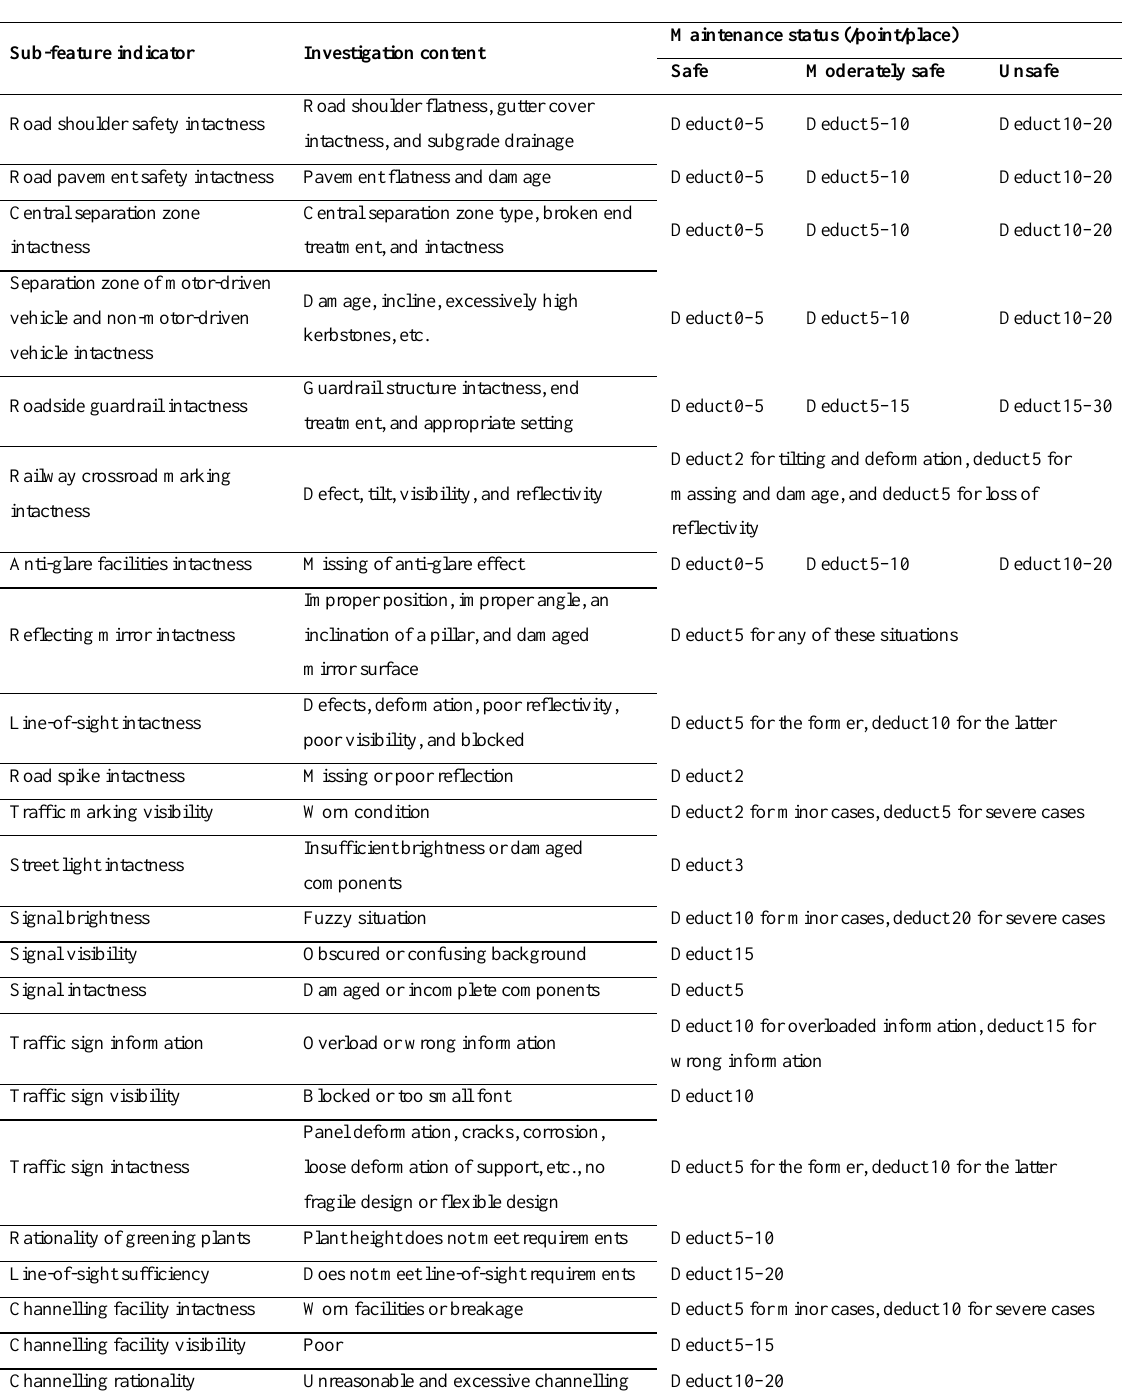
Table 4 Indicator deduction